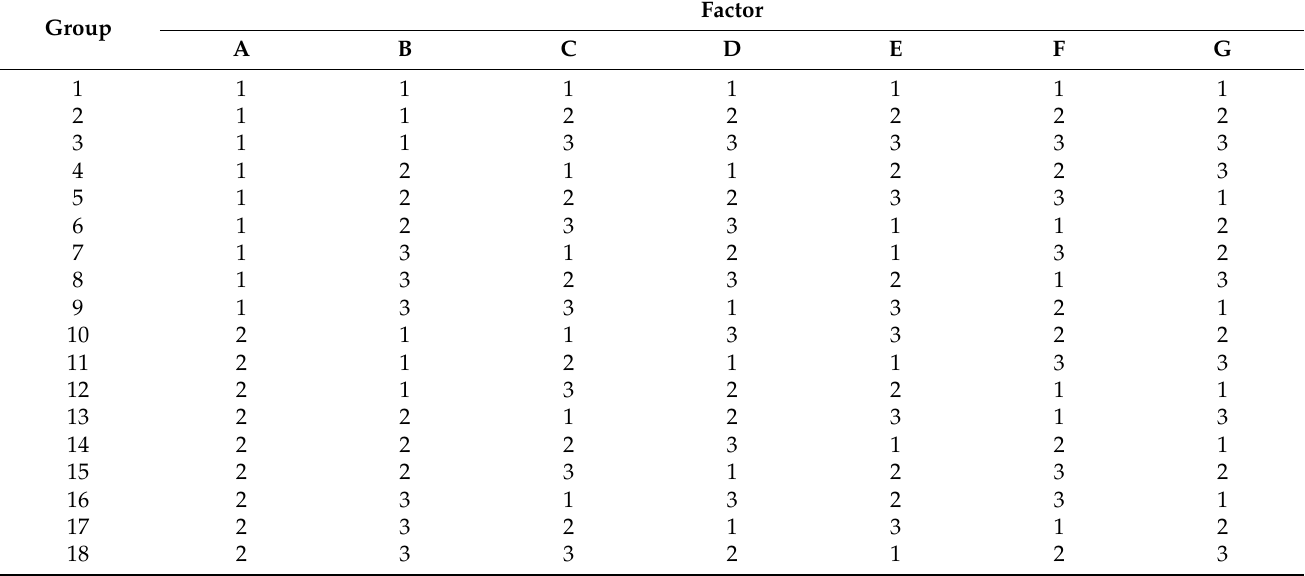
Table 1. The standard Taguchi’s L 18 (2 1 × 3 6 ) orthogonal array, where the numbers in each column, except the first one, indicate the specific factor (A–G) level or practical